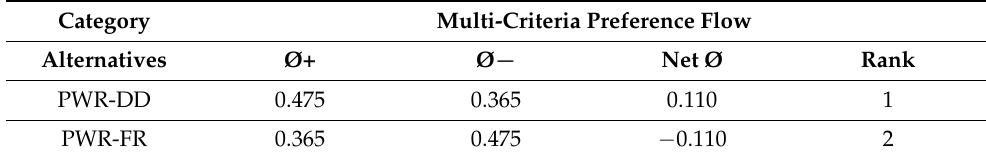
Table 7. Evaluation results of direct disposal and Pyro-SFR fuel cycle using PROMETHEE.